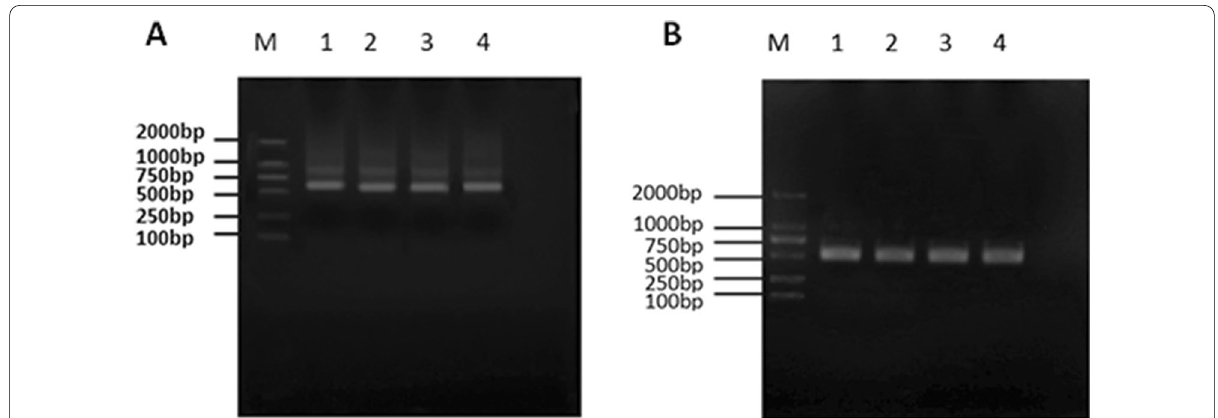
Fig. 3 Amplification of VHH gene. cDNA was used as a template, and a fragment containing the leader sequence to the CH2 region of the IgG (900 bp for VH and 600 bp for VHH) was amplified with primers P 1 and P 2 . The result is shown in Fig. 3( a ). The 600 bp fragment was purified using